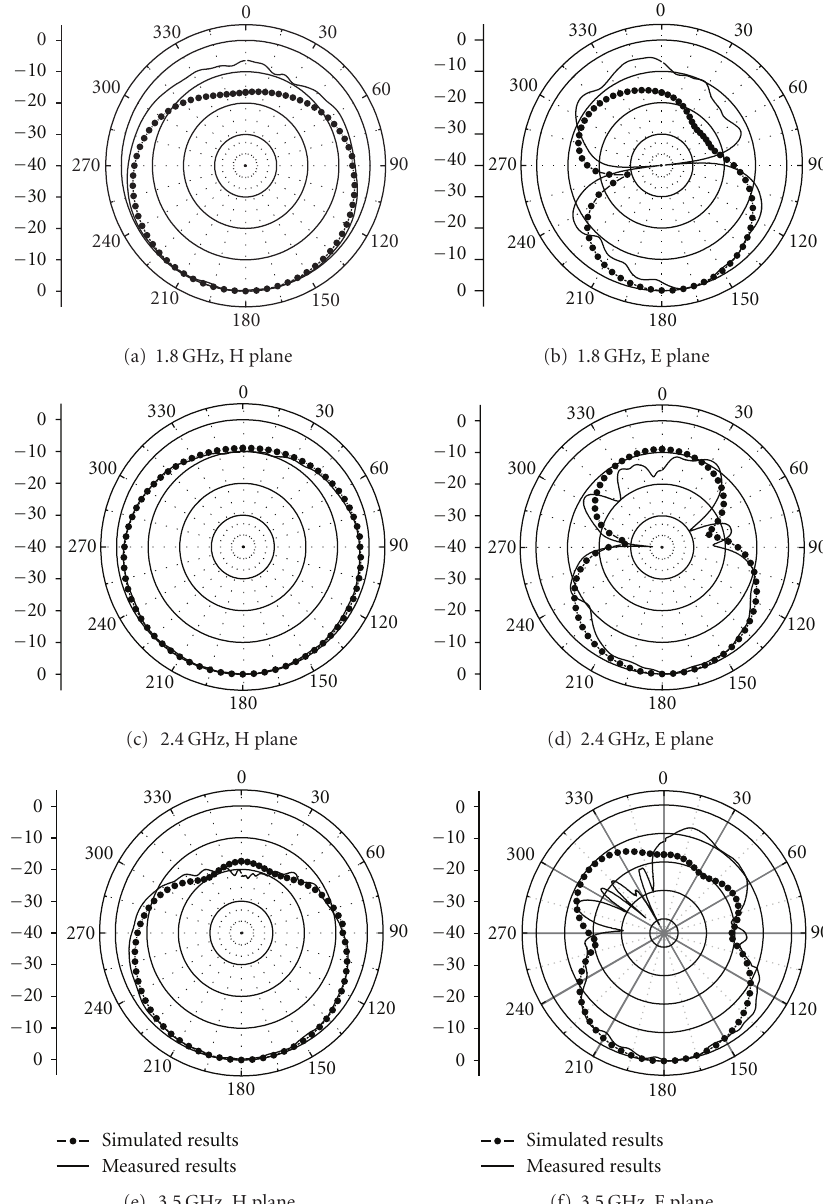
Figure 8: Simulated and experimental radiation patterns of the printed Yagi-Uda antenna unit.